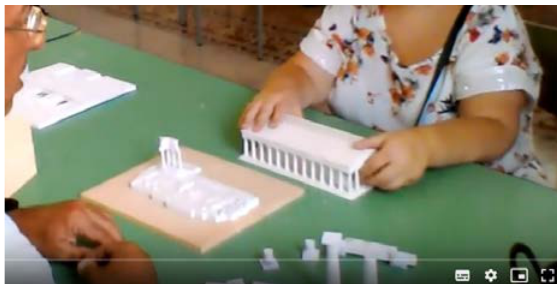
Figure 1. Tactile exploration of 3D models by blind